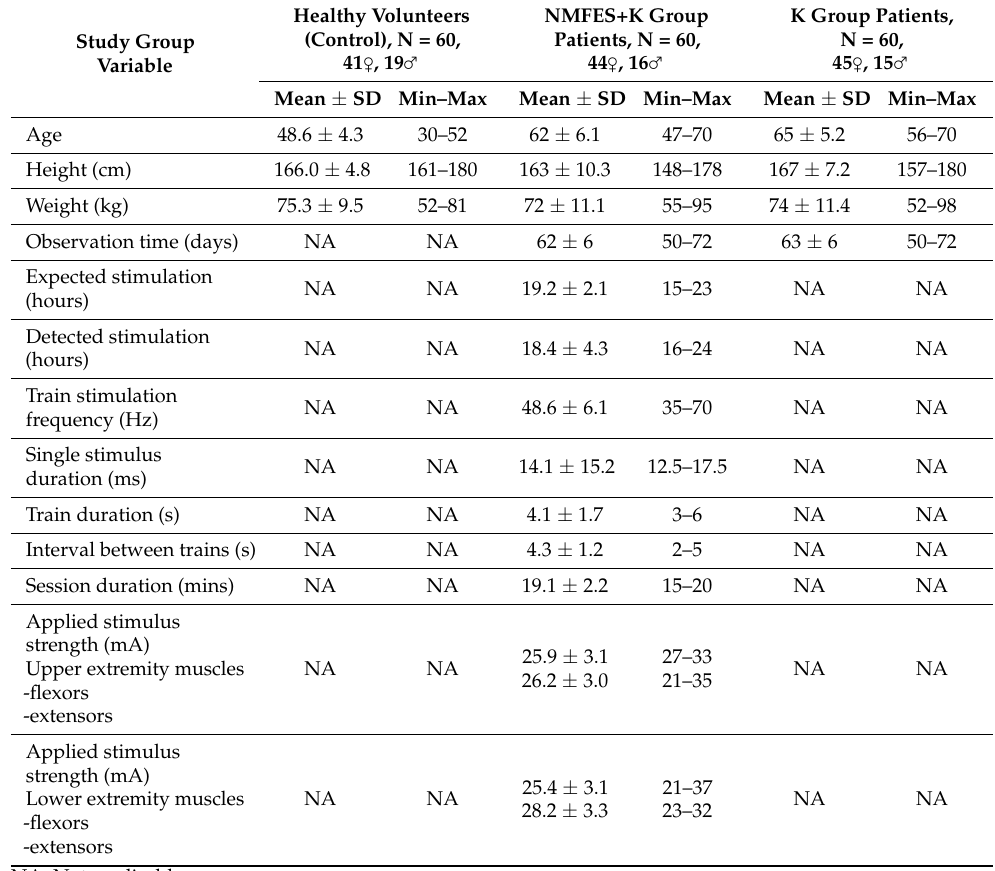
Table 1. Characteristics of the subjects and the summary of applied electrotherapy parameters. Study Group